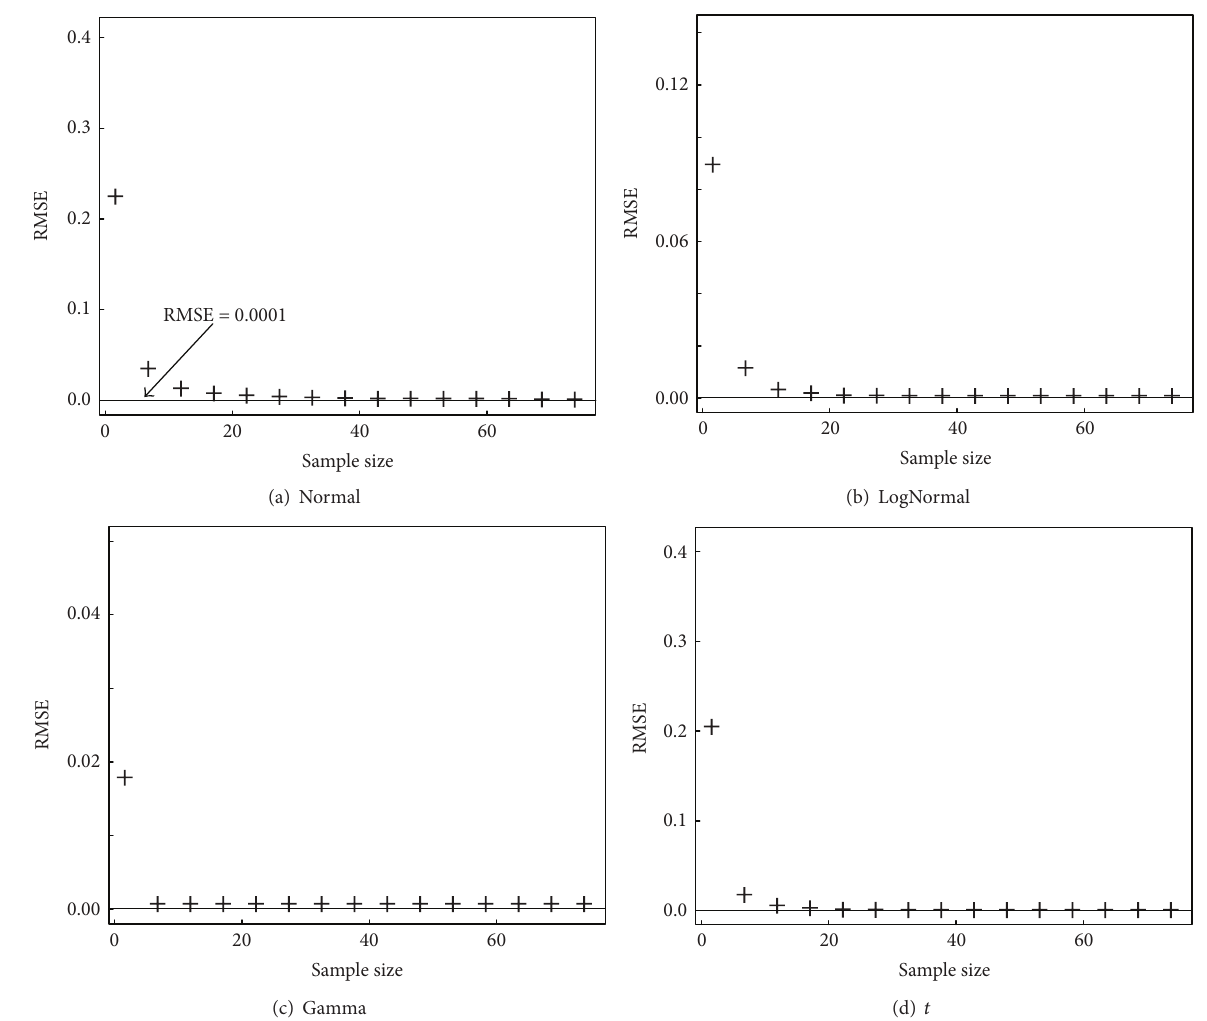
Figure 4: log (RMSE) versus sample size (nominal alarm probability is 0.001) for (a) normal, (b) lognormal, (c) gamma (1, 0.01), and (d) 𝑡(2) for two estimation options labeled 1 and 2, respectively. The true RMSEs were estimated by simulation of 10 4 observations in R , and results are repeatable to within ±0.0001